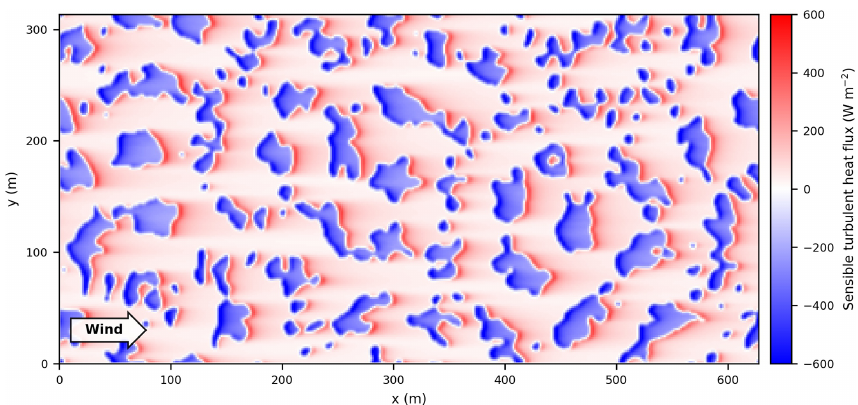
Figure 5. Time-averaged surface sensible turbulent heat fluxes. Sensible turbulent heat fluxes in the P15m simulation averaged from 2000 seconds until 2700s. Negative values indicate a downward flux, i.e., over snow patches, whereas positive values resemble an upward flux, i.e., over bare